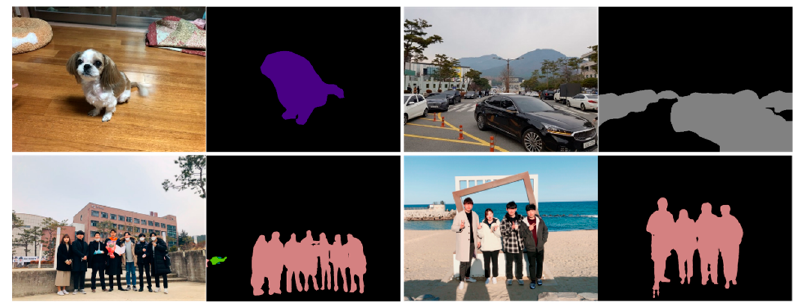
Table 4. Frame rate result of the proposed method for the PASCAL VOC 2012 database.